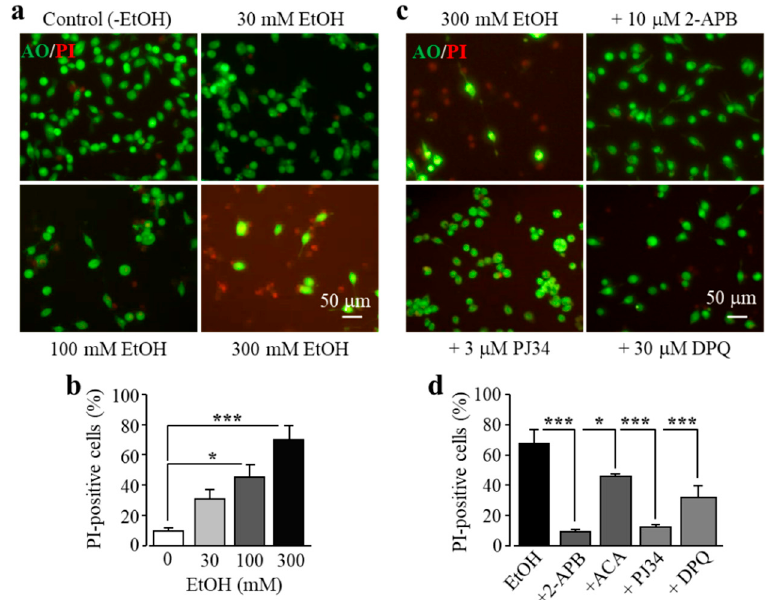
Figure 3. Ethanol (EtOH) induces BV2 microglial cell death via PARP-dependent TRPM2 channel activation. ( a , b ) Representative fluorescent images showing co-staining with PI and acridine orange (AO) ( a ) and mean percentage of PI-positive cells ( b ) in cells without (control) and with exposure to indicated concentrations of EtOH for 24 h. ( c , d ) Representative fluorescent images showing co-staining with PI and AO in cells exposed to 300 mM EtOH for 24 h without and with treatment with indicated inhibitors ( c ) and mean percentage of PI-positive cells from three independent experiments, using three wells of cells for each condition in each experiment ( d ). Cells were pre-treated with inhibitors 30 min prior to and during exposure to EtOH. * p < 0.05; *** p < 0.005 compared to indicated control group.